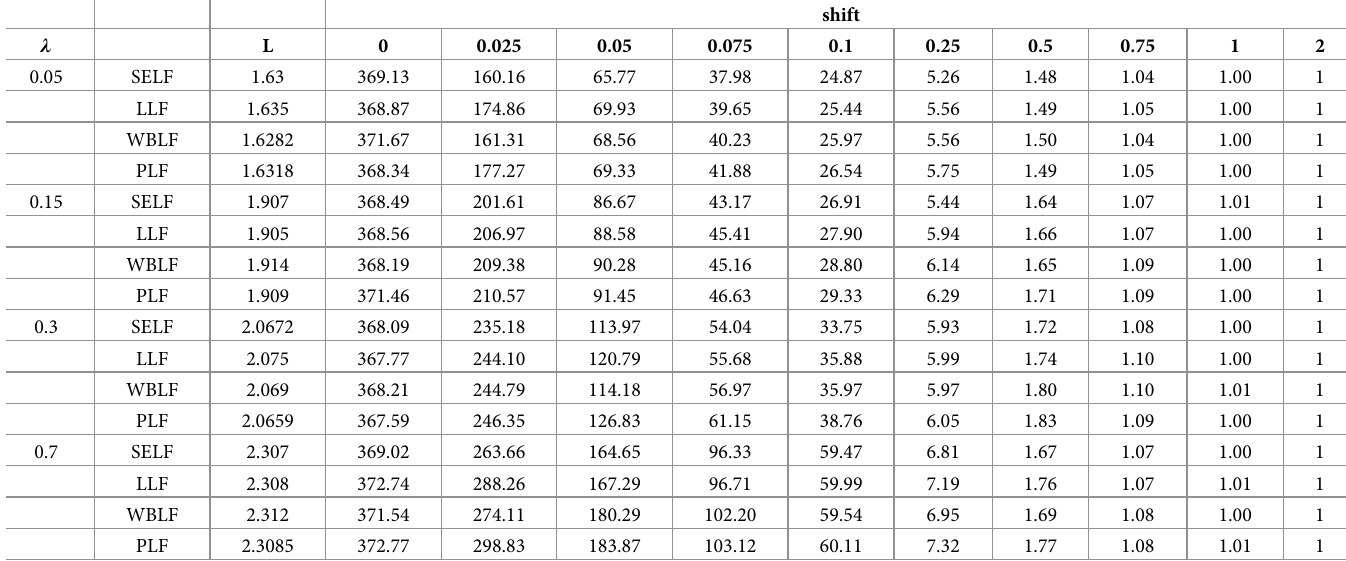
Table 3. ARL comparison for n = 20 under various loss function for ARL 0 = 370.